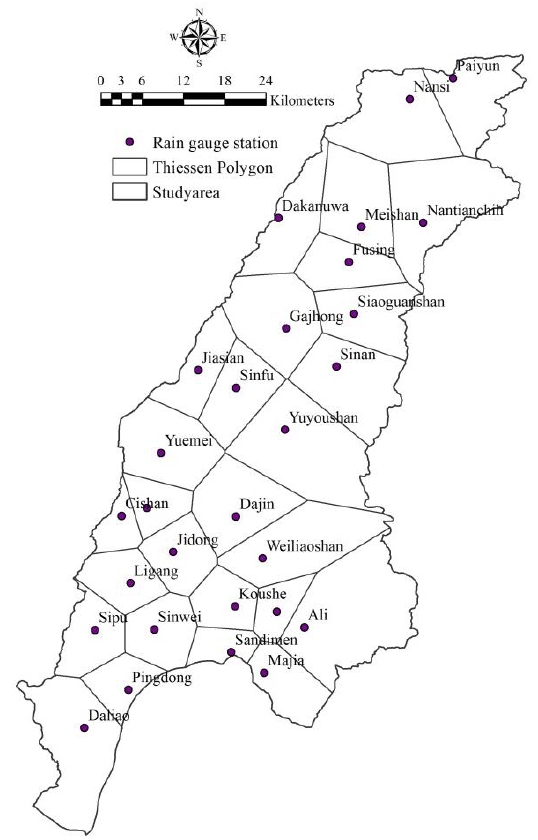
Figure 9. Effective area for precipitation gauging stations in the Gaoping River watershed. Figure 9. E ff ective area for precipitation gauging stations in the Gaoping River